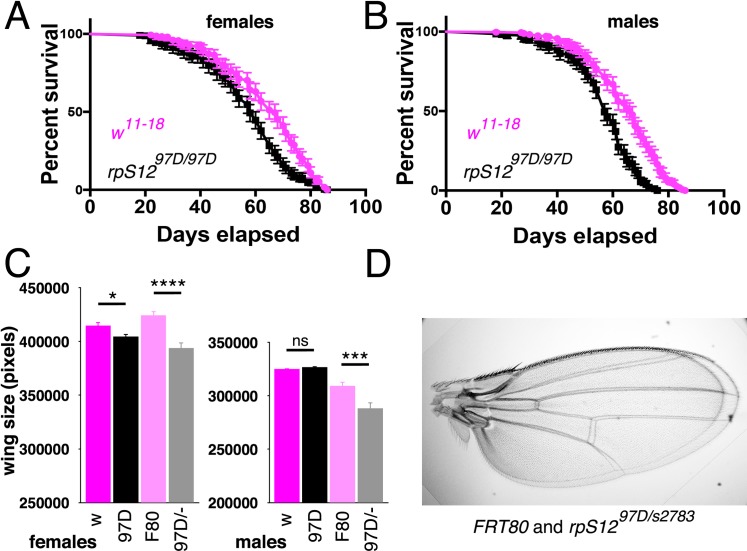
Contributions of RpS12 to longevity and organ size.A) Survival curve of female rpS12G97D flies compared to w11-18 (wild type) controls. Shown is the mean are 95% confidence limits from 3 replicates of 120 flies each. B) Survival curve of male rpS12G97D flies compared to w11-18 (wild type) controls. The difference is significant at p<0.0001 Log-rank (Mantel-Cox) test. See the S3 Fig for individual replicates and the S5 Table for raw data. C) Adult wing size was significantly smaller for the rpS12G97D females compared to w11-18 (p = 0.0165, two-tailed Welch’s t-test) and for rpS12G97D/- females compared to FRT80B (p = 0.000006, two-tailed Welch’s t-test). Wing size was also smaller for rpS12G97D/- males compared to FRT80B (p = 0.00014, two-tailed t-test) but not for rpS12G97D males compared to w11-18 (p = 0.126, two-tailed t-test). Raw data are tabulated in the S7 Table. D) Wings from rpS12G97D/- and FRT80B females overlaid to illustrate the difference. The rpS12G97D/- wing is smaller.